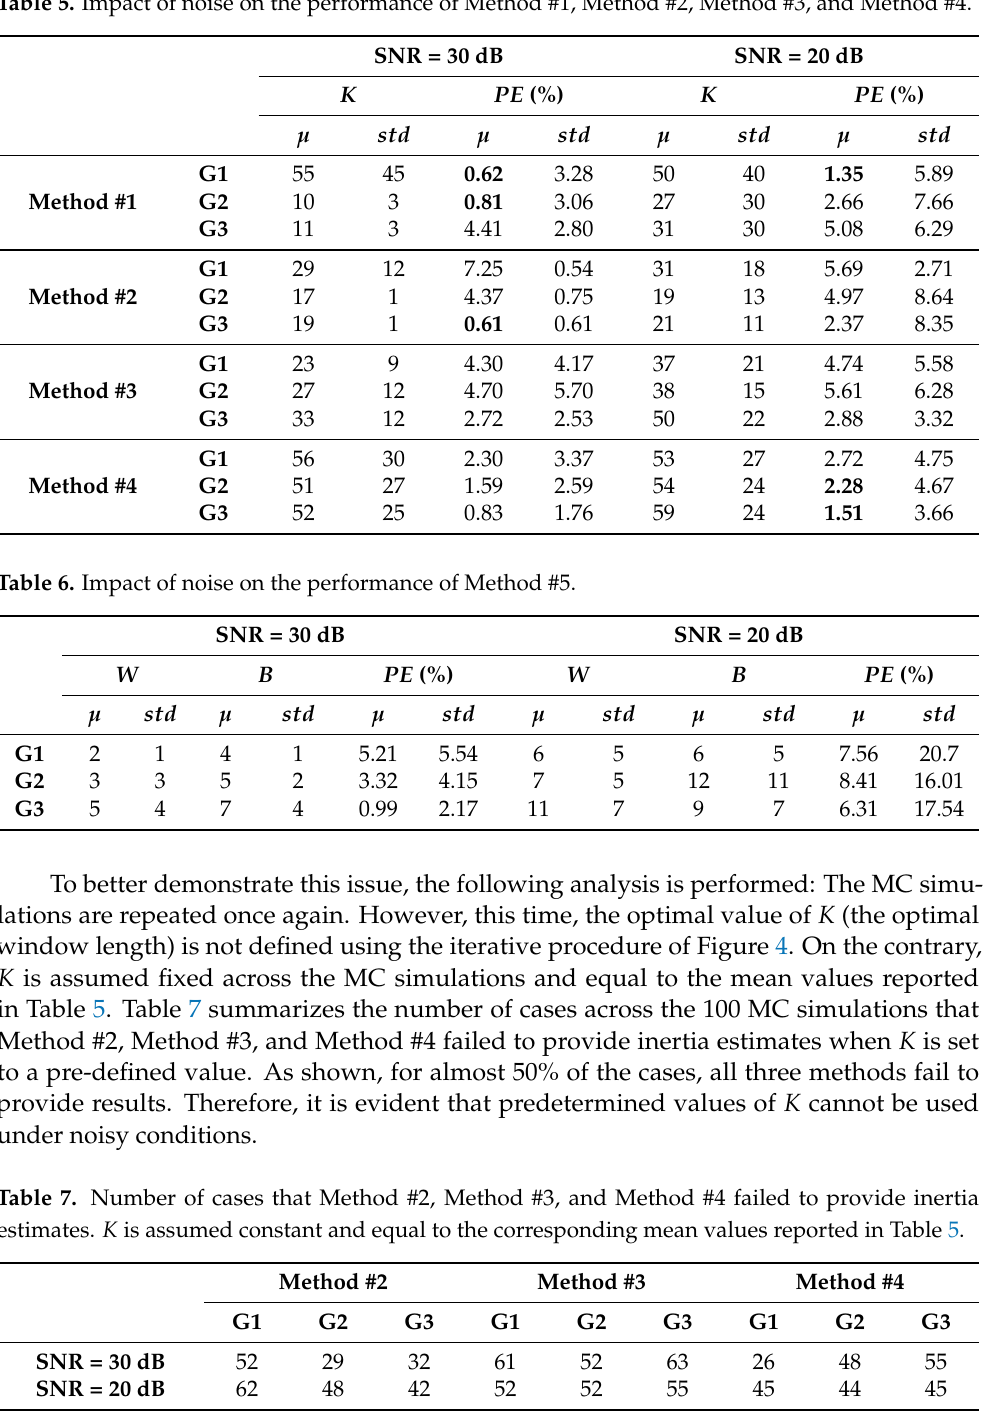
Table 5. Impact of noise on the performance of Method #1, Method #2, Method #3, and Method #4.